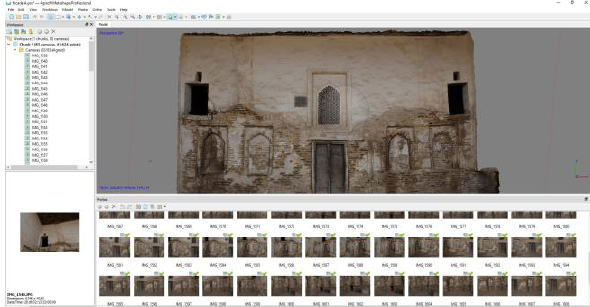
Figure 3. 3D model showing the north interior façade of the Bogbonli Mosque. Source: authors.